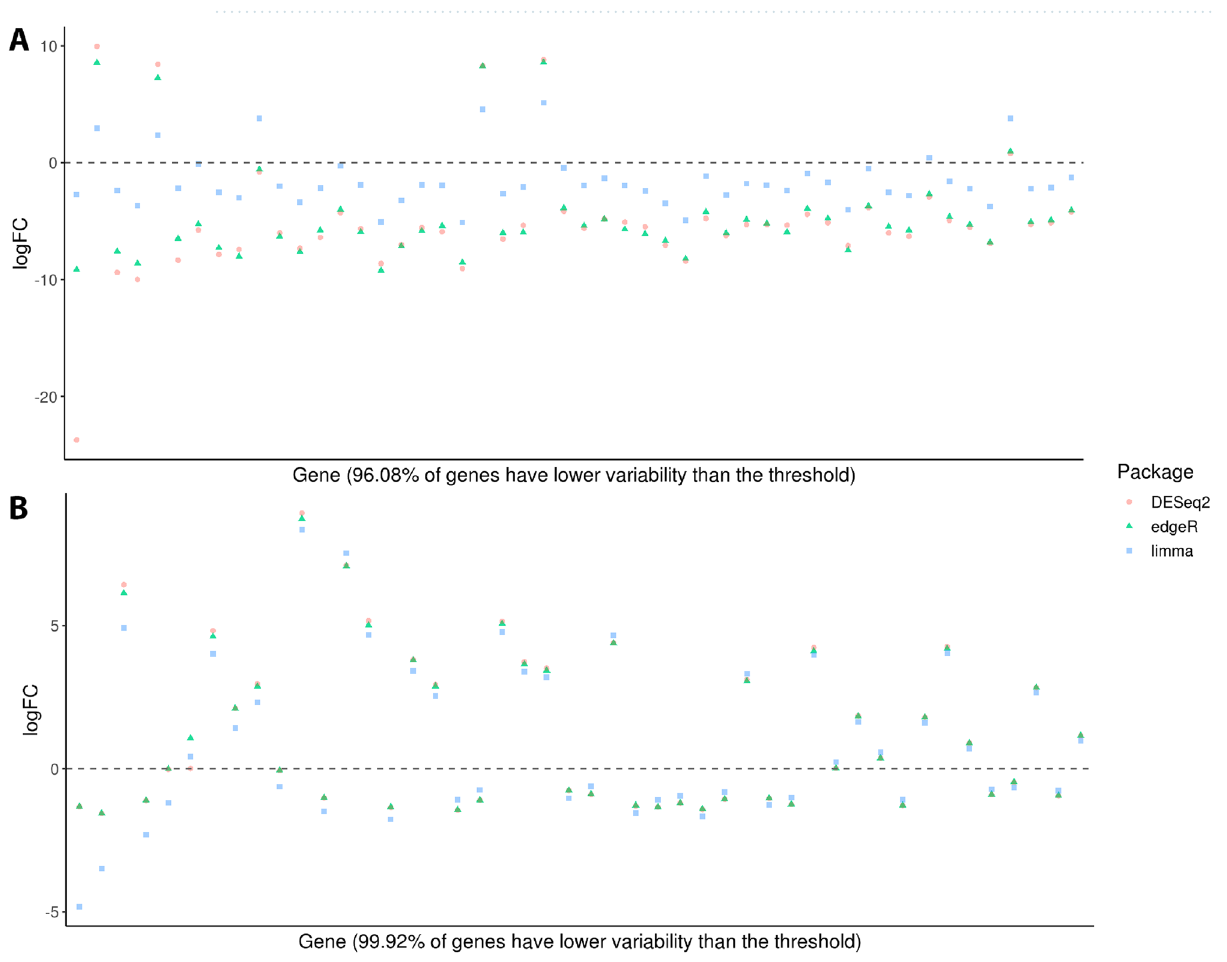
Figure 5. Log2 fold change values according to the different DEG detection methods for a subset of genes from the ( A ) PMM2-CDG and ( B ) Lafora disease datasets. Genes chosen based on the variance of estimated log2 fold change values across all three methods ( ≥ 0.01 ). Genes ordered along the x-axis by decreasing variance. The Lafora disease dataset showed relatively few genes with significant variance in terms of